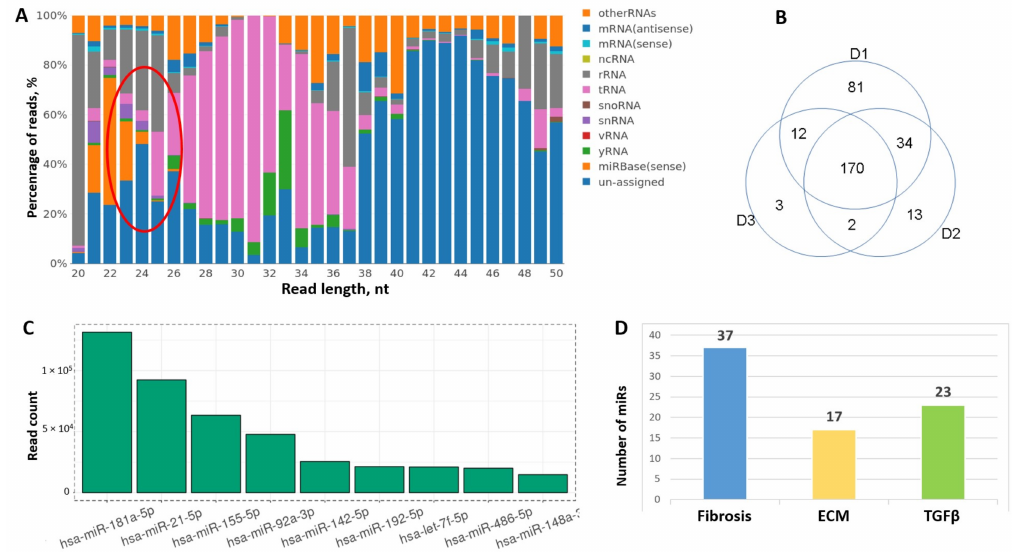
Figure 9. Analysis of RNA profile in MSC-EV by RNA-seq. ( A ) Di ff erent types of RNAs are represented in MSC-EV. Cluster of microRNAs marked by red oval. ( B ) Variability of microRNA representation in donor adipose tissue-derived MSC-EV by Venn diagrams. ( C ) The most abundant microRNAs in MSC-EV (top-10). ( D ) Fibrosis-associated microRNA representation in MSC-EV based on their predicted gene target